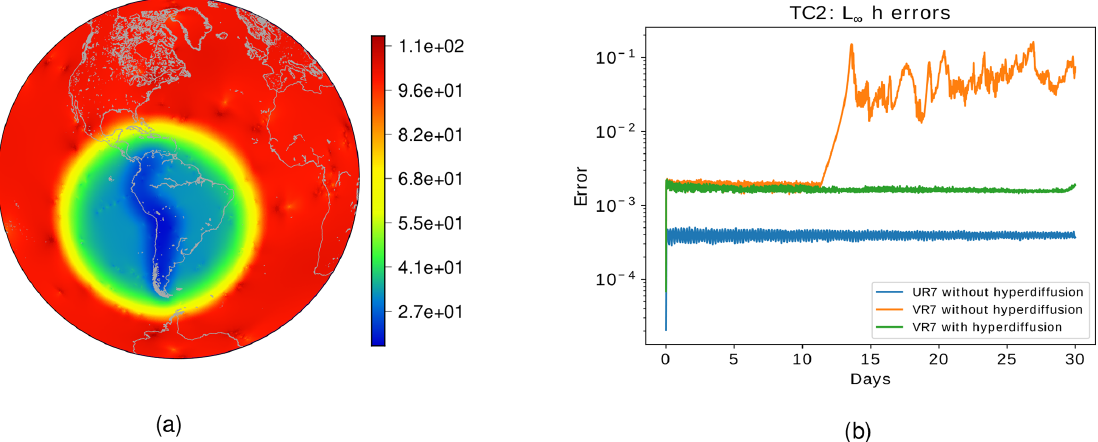
Figure 11. (a) Diameters in kilometers for the variable-resolution grid with 1:6 coarse-to-fine cell ratio. The grid level is equal to 7. (b) Steady geostrophic flow test case showing the time evolution of relative error in the L ∞ norm for the height field considering the variable-resolution grid with a 1:6 coarse-to-fine cell ratio. The blue lines indicate the errors for the uniform SCVT grids, while the orange lines show the error for the variable-resolution grids with refinement based on topography with 1:6 coarse-to-fine cell ratio, and the green lines show the error for the same variable-resolution grids but adding numerical fourth-order hyperdiffusion based on the alignment index with K max = 10 12 m 4 s − 1 in the shallow-water